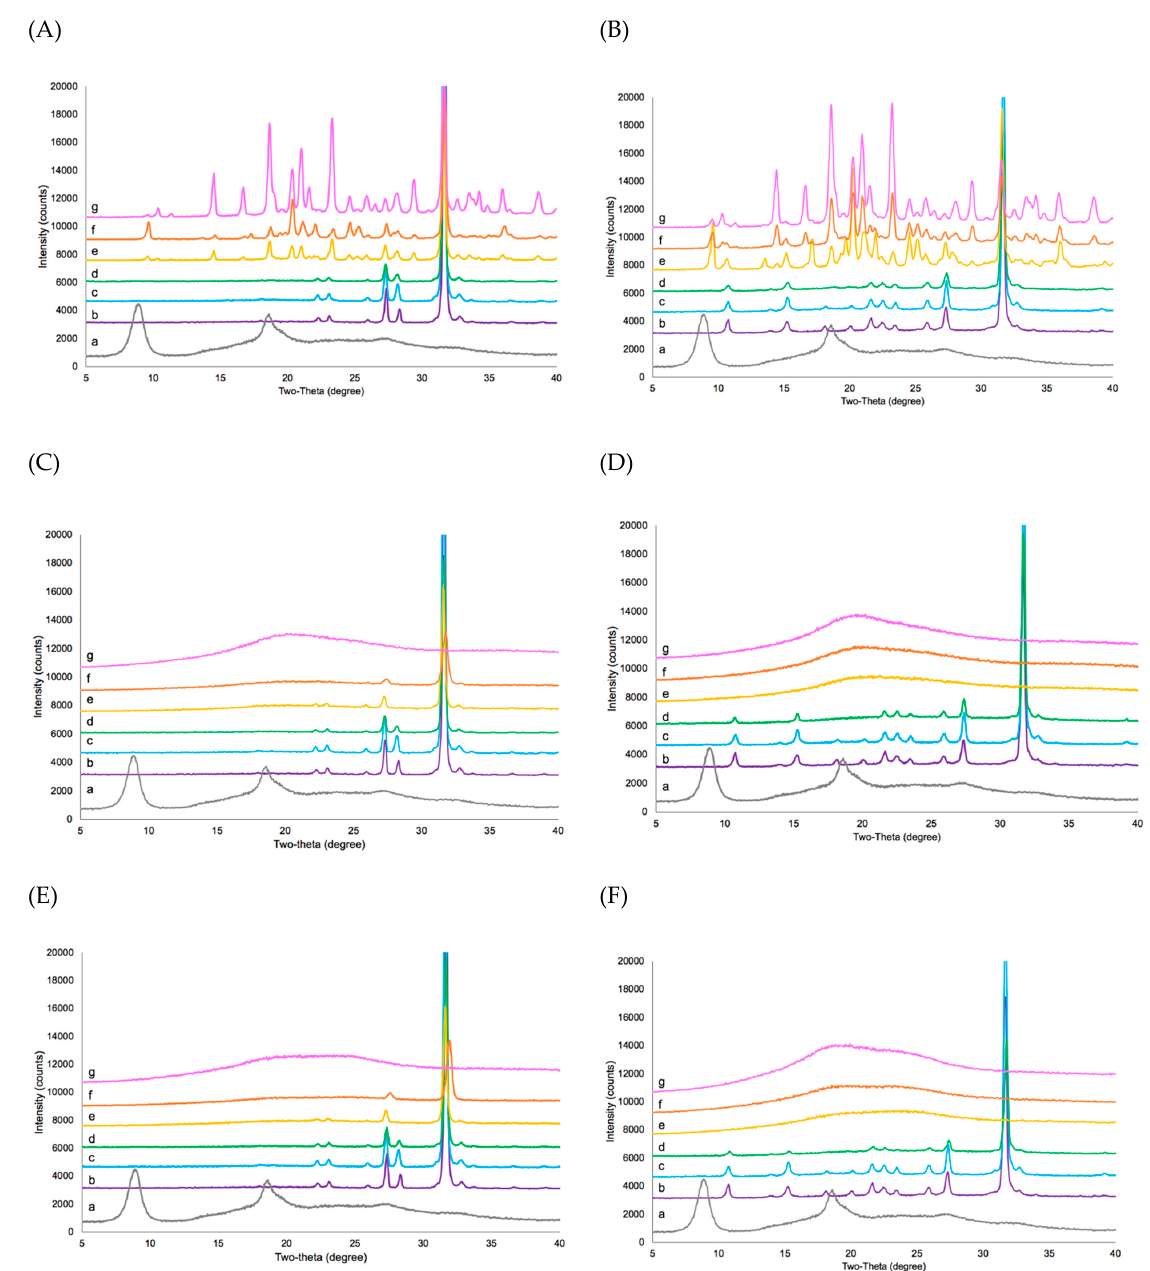
Figure 9. X-ray diffraction patterns: ( A ) lyophilized mannitol (DPBS) formulations; ( B ) lyophilized mannitol (TBS) formulations; ( C ) lyophilized lactose (DPBS) formulations; ( D ) lyophilized lactose (TBS) formulations; ( E ) lyophilized trehalose (DPBS) formulations; ( F ) lyophilized trehalose (TBS) formulations. [a: CSP7 acetate, b: lyophilized pure buffer, c: lyophilized neat CSP7, d: lyophilized 1:5-CSP7:bulking agent, e: lyophilized 1:70-CSP7:bulking agent, f: lyophilized 1:140-CSP7:bulking agent, g: lyophilized 1:320-CSP7:bulking agent].